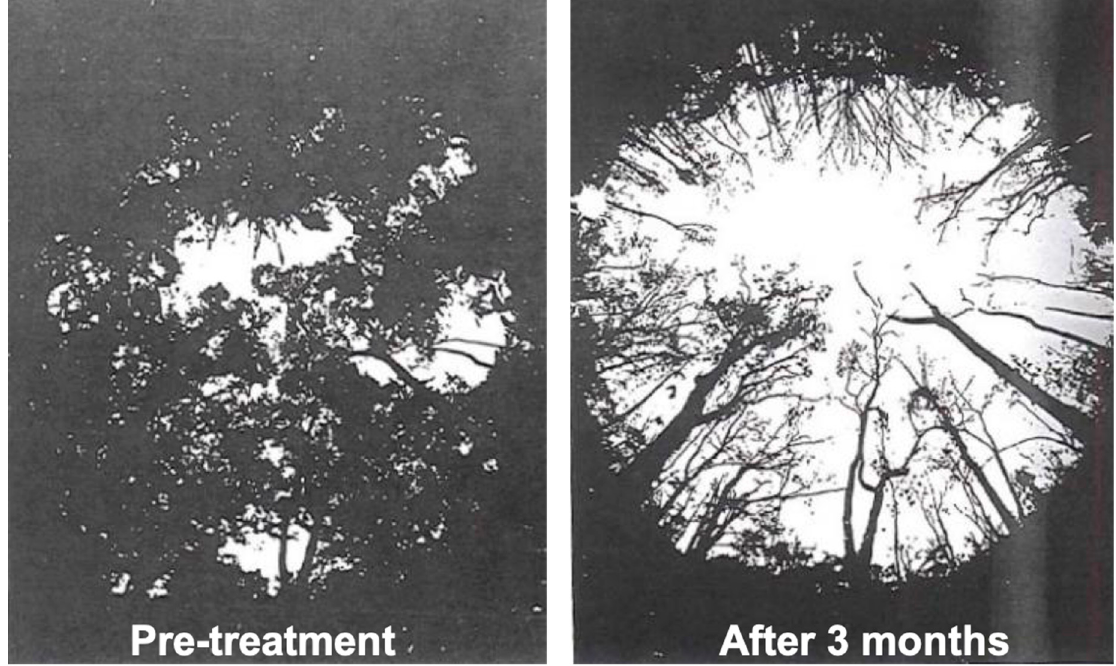
Figure 3. Changes in canopy opening prior to and three months following herbicide application in the Luquillo Experimental Forest. Photograph reproduced from [18] . 298